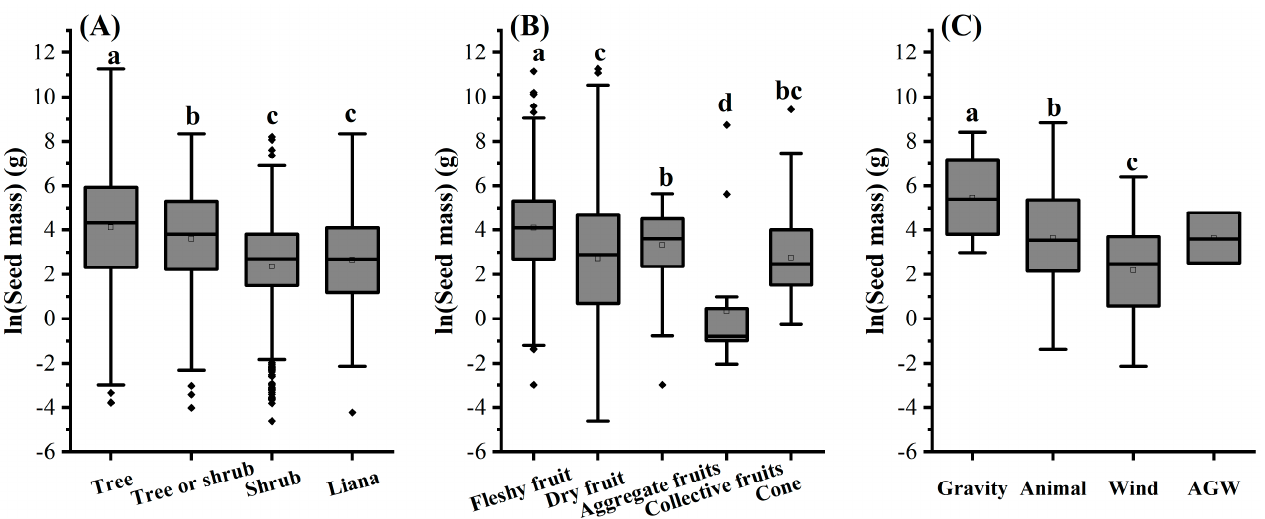
Figure 3. Relationship between seed mass and functional traits in woody plants. Differences in seed mass of species with ( A ) different growth forms (tree, shrub or small tree, shrub, and liana); ( B ) different fruit types (fleshy fruit, dry fruit, aggregate fruits, collective fruits, and cone); ( C ) different seed dispersal modes (gravity dispersal, animal dispersal, wind dispersal, and a variety of seed dispersal methods). The horizontal lines represent the 25%, 50%, and 75% quantiles. The vertical lines show the 5% and 95% quantiles. Diamond-shaped points represent outliers. The different lowercase letters indicate significant differences in the seed mass ( p < 0.05).